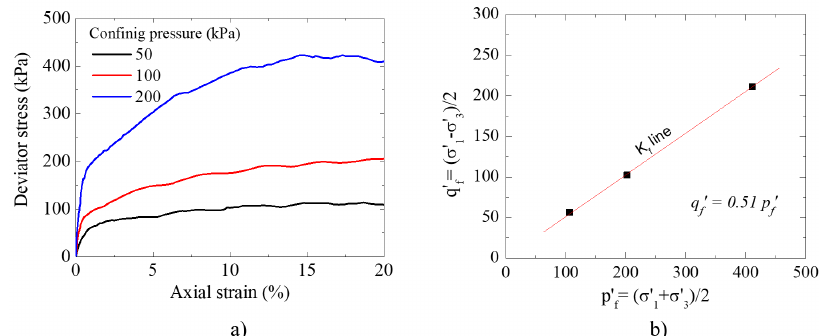
Figure 6 - Results of CID triaxial tests performed on the slightly clayey fine sand: a) Deviator stress v. axial strain relationships for varying confining pressures; b) p-q diagram.